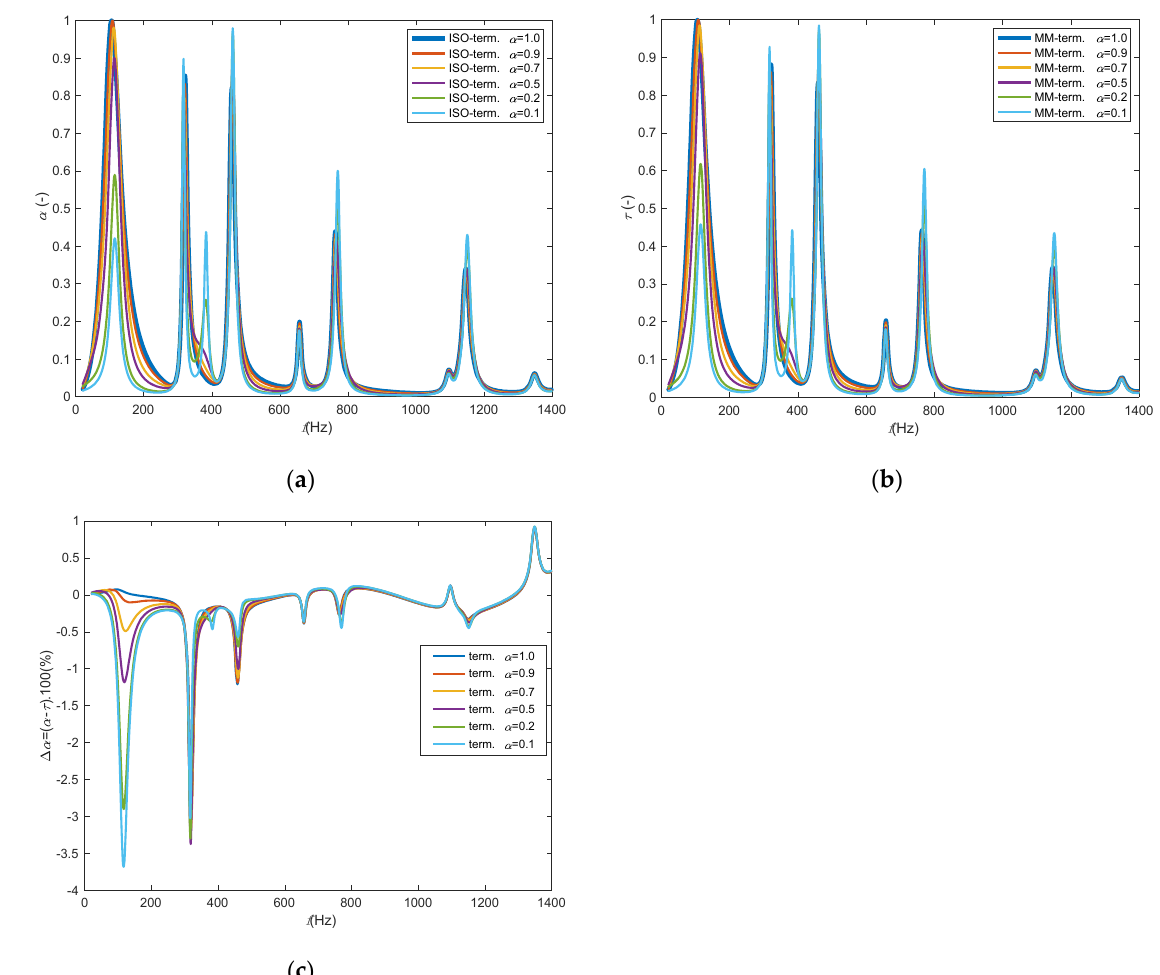
Figure 10. Normal-incidence sound absorption of a single leaf PTFE rectangular shape membrane determined for six different terminations (variation of termination (“term.” in the legend) absorption from α = 0.1 to 1, data were obtained from FEM). ( a ) TFM-ISO 10534-2 (“ISO” in the legend); ( b ) mobility-based method (“MM” in the legend); and ( c ) difference between sound absorption obtained by means two methods expressed in percentage.